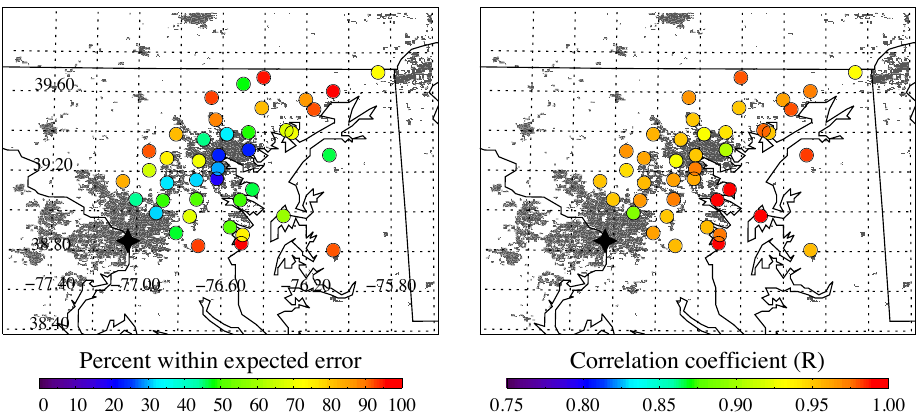
Fig. 8. (a) Percent of 3km spatially averaged MODIS/SP collocations of 0.55µm AOD within expected error ( ± 0.05 ± 0.15AOD) at each SP station. (b) Correlation coefficient between 3km spatially averaged MODIS 0.55µm AOD and SP temporally averaged 0.55µm measure- ments at each station. Land identified as urban/built up by the MODIS land cover product (MCD12Q1) is plotted in grey in both panels.